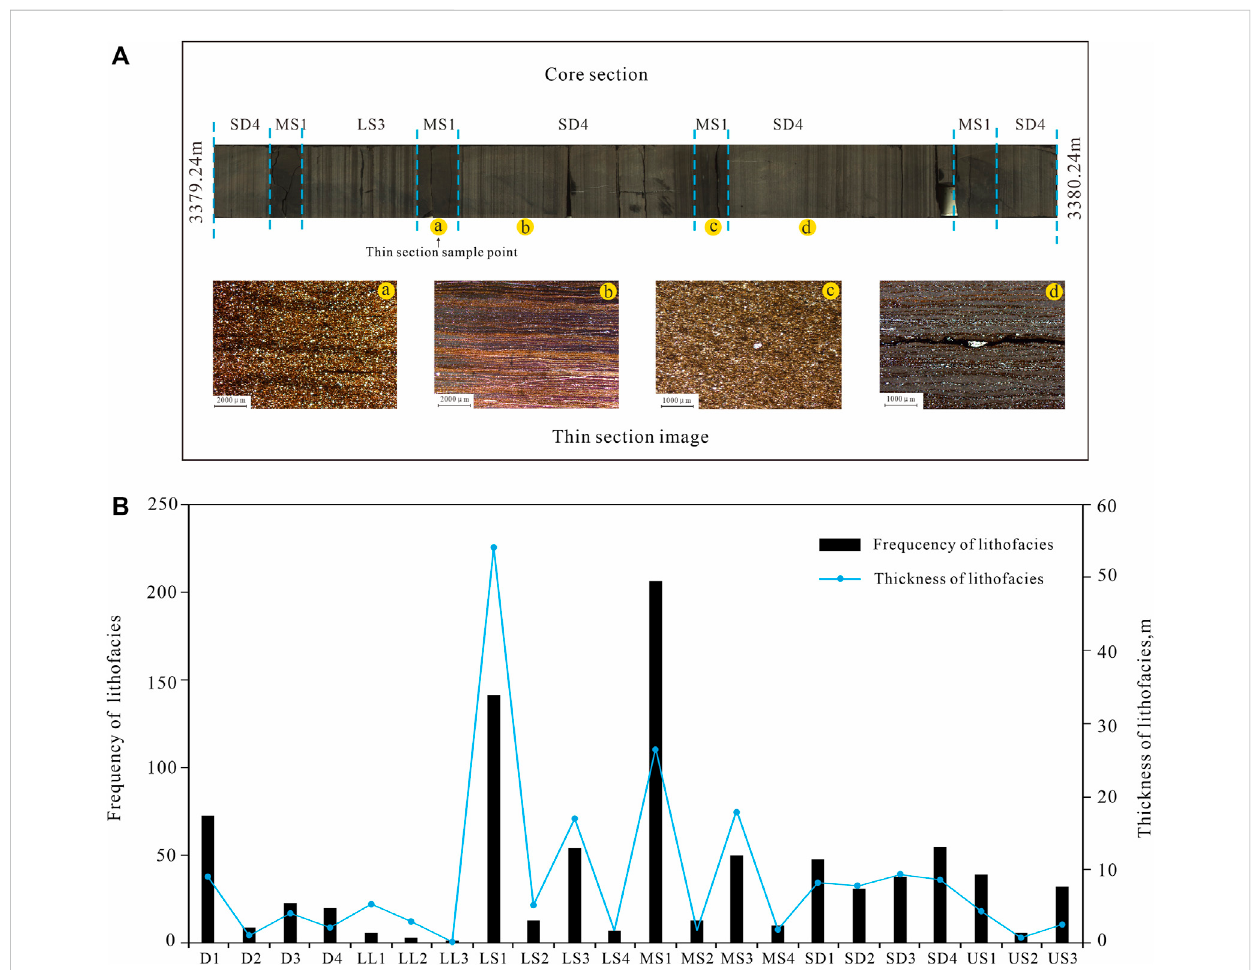
FIGURE 3 Example of vertical lithofacies division (A) and frequency and thickness statistics of different lithofacies types (B) .